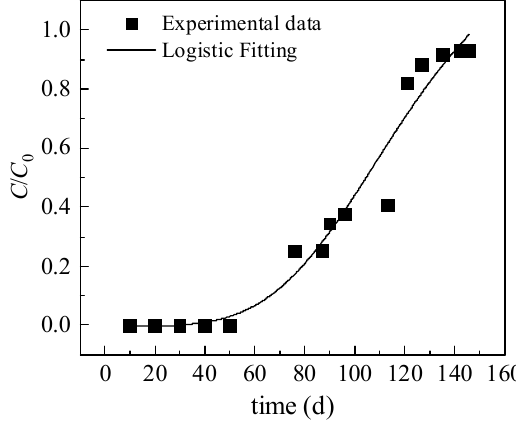
Figure 5. Dynamic adsorption test results with logistic fitting curve.